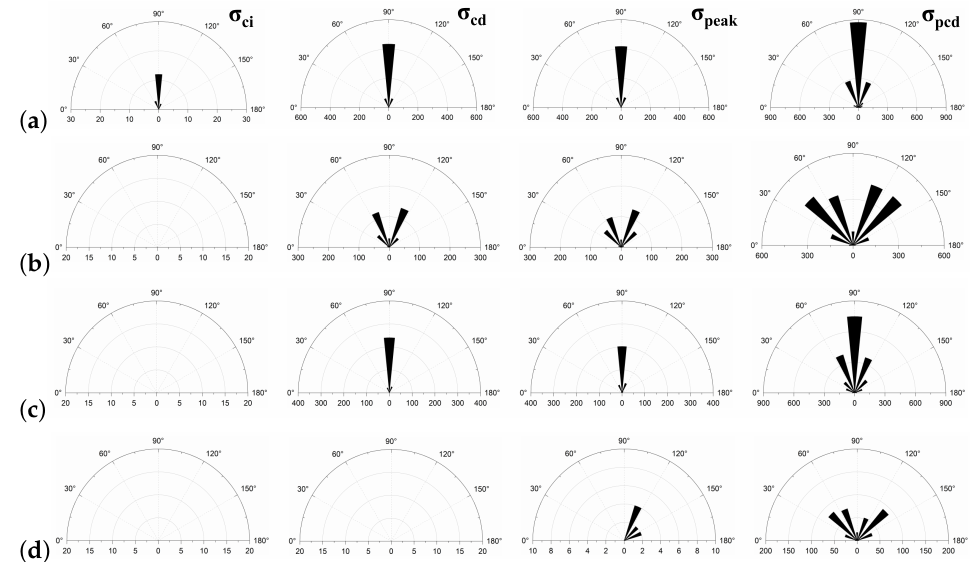
Figure 14. The crack number and angle statistics at the four stress values of σ ci , σ cd , σ peak and σ pcd during the crack evolution process: ( a ) the number of Boundary-tensile crack angles ( b ) the number of Boundary-shear crack angles ( c ) the number of Transgranular-tensile crack angles ( d ) the number of Transgranular-shear crack angles.